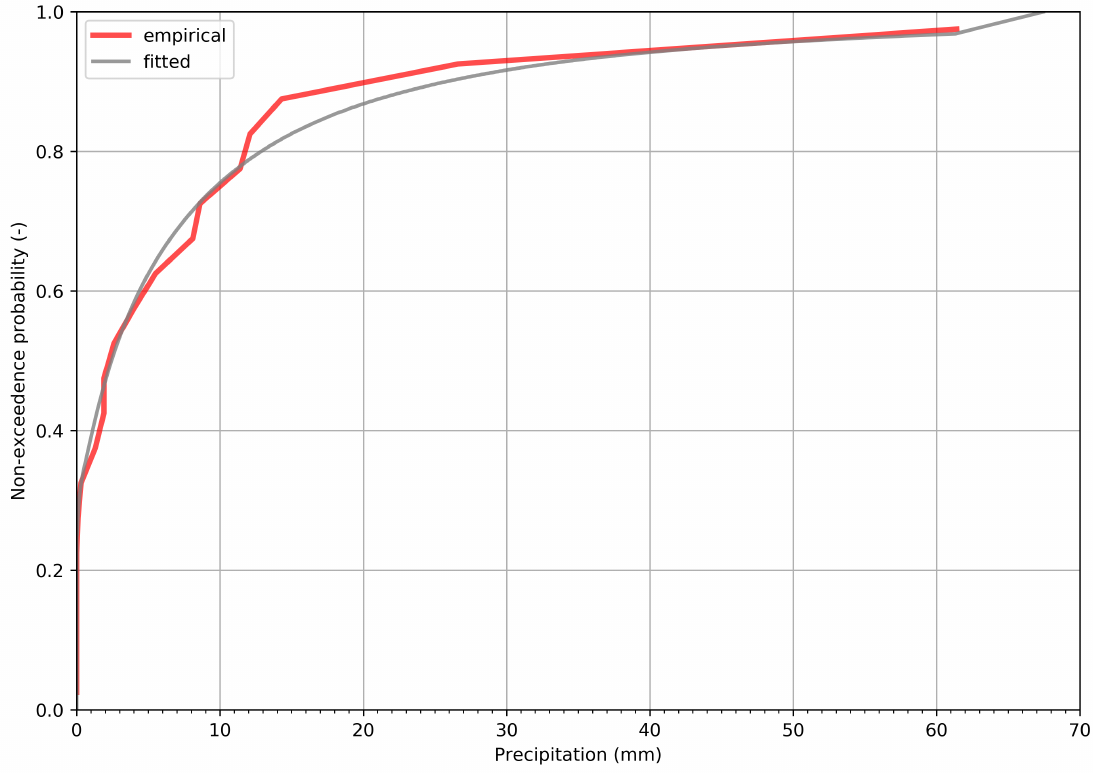
Figure 9. Empirical and fitted non-parametric distributions for the 24 December 1882